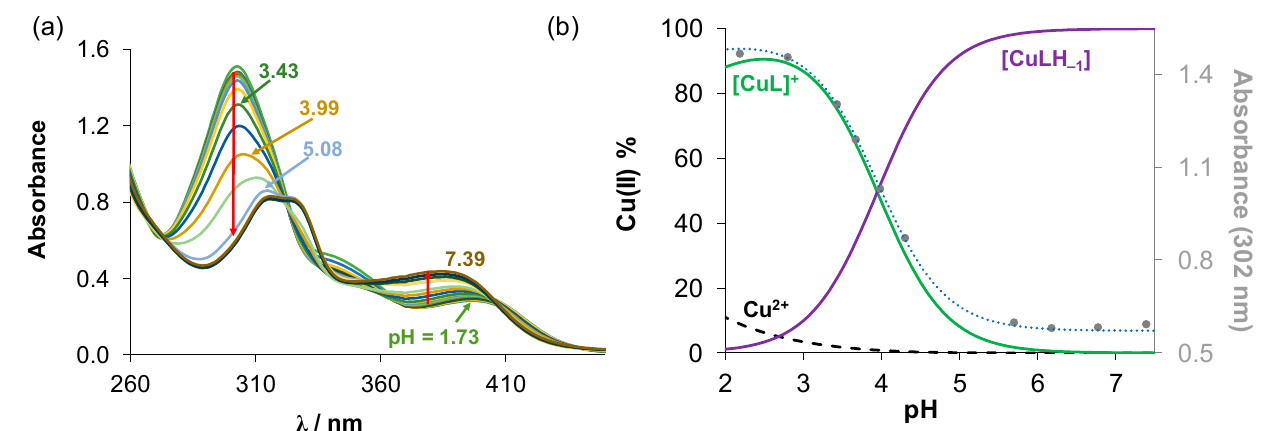
Figure 2. ( a ) UV–vis absorption spectra of the Cu(II)-estradiol-TSC (1:1) system in the pH range 1.73 ‒ 7.39 in 30% ( v/v ) DMSO/H 2 O solvent mixture. ( b ) Concentration distribution curves calculated for the same system plotted together with the absorbance changes at 302 nm ( • ) with the fitted curve (dotted line). (c ligand = 20 µ M; c Cu (II) = 20 µ M; T = 25.0 ◦ C; I = 0.1 M (KCl)). Therefore, estradiol-(T)SCs form only mono-complexes [CuL] + and [CuLH − 1 ] at pH < 7.5. Complex [CuL] + is formed in the acidic pH range, where the ligands coordinate in a tridentate mode via (O − ,N,S)(H 2 O) for estradiol-TSCs and via the (O − ,N,O)(H 2 O) donor set for estradiol-SC, respectively. Further deprotonation of hydrazonic nitrogen leads to the formation of complex [CuLH − 1 ], which is the sole species between pH 5 and 7.4. The suggested structures for the complexes formed with estradiol-TSC are represented in Scheme 2. The deprotonation of the coordinated co-ligand water is feasible only at pH > 9 based on the p K a values of [CuL] + species determined for the estrone derivatives [8,22,23].